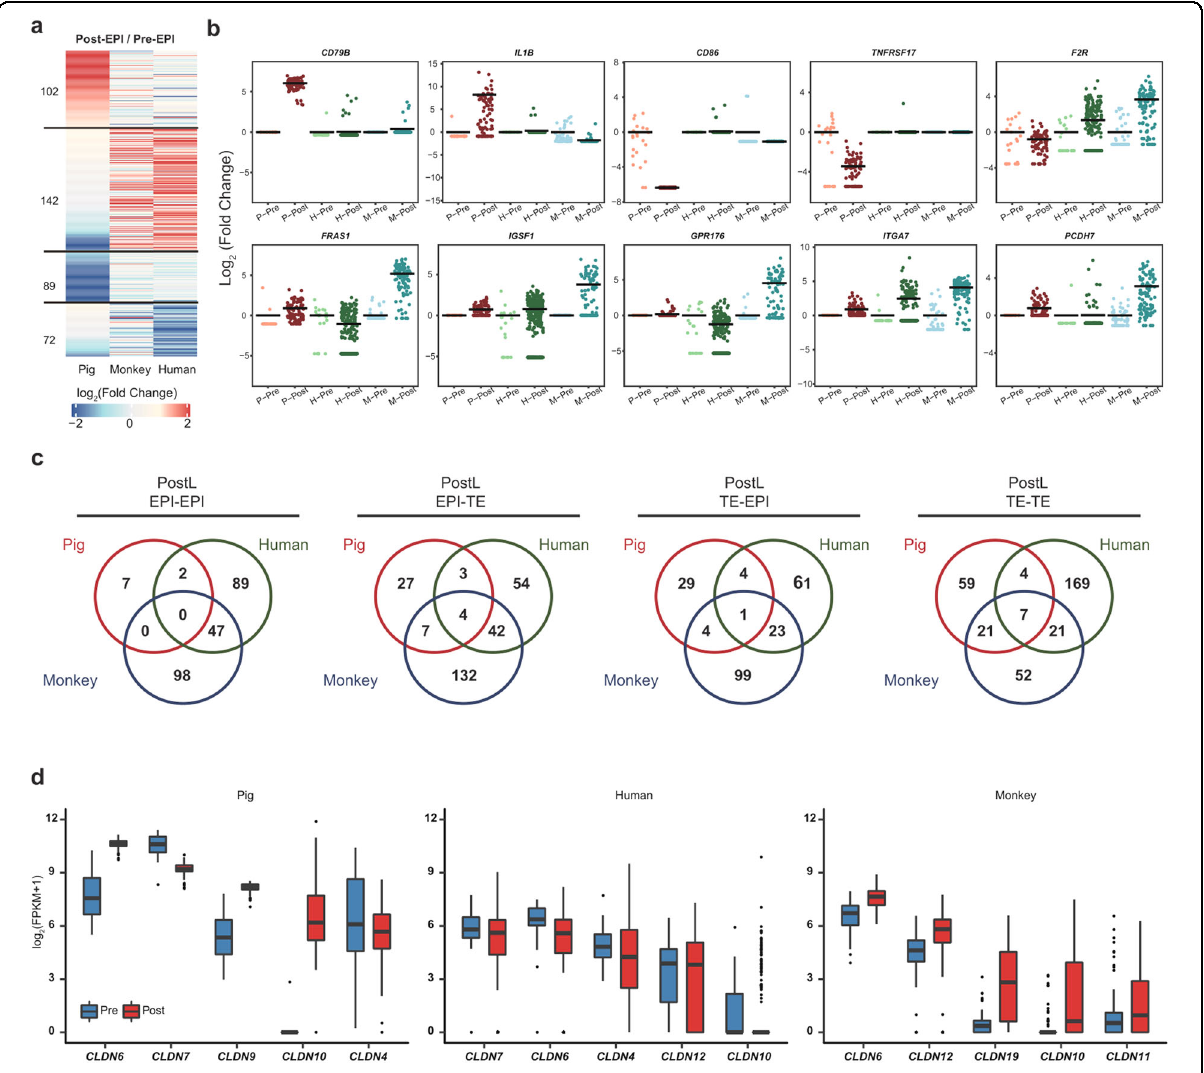
Fig. 5 Cross-species comparison of membrane-related genes among pig, monkey and human EPIs. a Heatmap of differential expression of cell surface proteins in Pre- and Post-EPIs in pig, human, and monkey. b Scatter-plot of genes encoding species-speci fi c surface proteins. P-Pre, pig ICM and Pre- EPIs; P-Post, pig PostE- and PostL- EPIs; H-Pre, human D6-EPIs; H-Post, human D8- and D10-EPIs; M-Pre, monkey ICM and Pre-EPIs; M- Post, monkey PostE- and PostL-EPIs. Using Pre-EPIs as a control, fold change of gene expression in each cell relative to the average expression level in Pre-EPIs was calculated. c Overlaps of the interaction relationship between PostL-EPIs and PostL-TEs in each species. d Box plot showing the expression of top 5 claudin genes in Pre- and Post- EPIs in each species. Stage information was indicated as follows: Pre-, Day 5 or/and Day 7, PreE-, Day 5; PreL-, Day 7; Post-, Day 10 and Day 12; PostE-, Day 10; PostL-, Day 12. The horizontal lines in b indicate the mean values. To avoid the in fl uence caused by the “ 0 ” value, a new matrix was generated by using FPKM + 1 and the log 2 -transformed fold change was